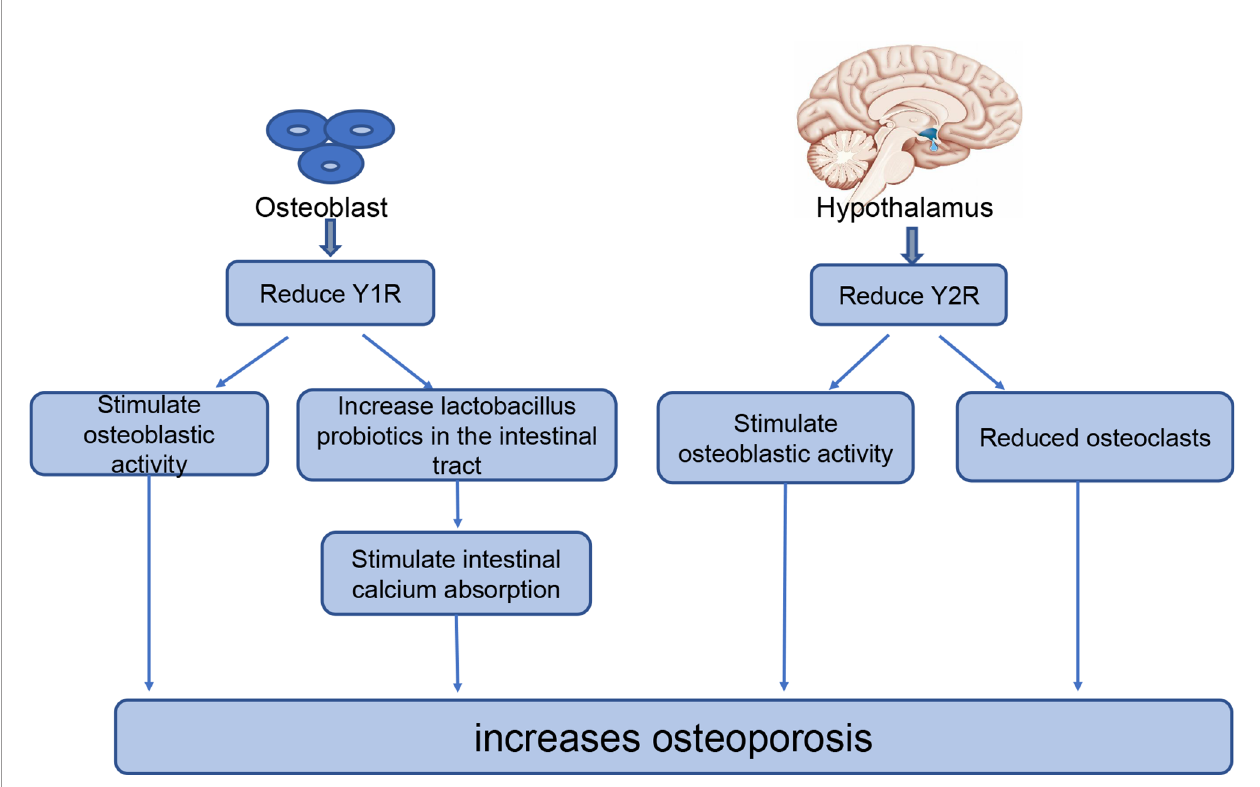
FIGURE 1 | The role of NPY in bone homeostasis. NPYR1 is expressed in osteoblasts and NPYR2 is expressed in the hypothalamus, where they play key roles in bone homeostasis. Reducing NPYR1 increases osteogenesis by increasing the activity of osteoblasts and the level of lactobacillus probiotics in the intestinal tract. Reducing NPYR2 increases osteogenesis by promoting osteoblastic activity and reducing the number of